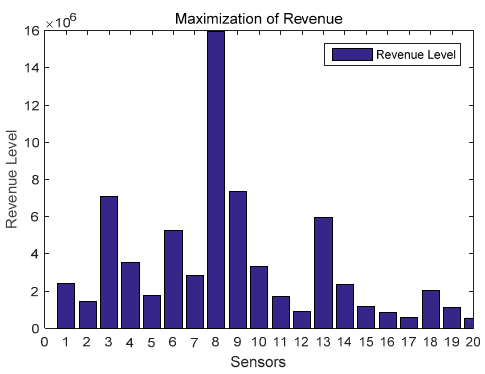
Figure 8. Revenue level of each sensor.